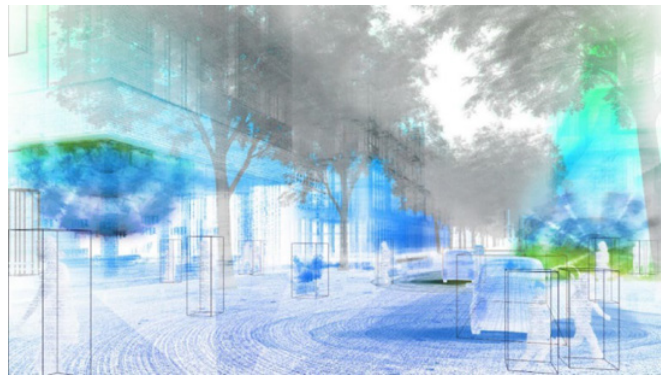
Figure 5 Physical and digital layers Source: (Sidewalk Labs, 2017, p.71). Credit: Sidewalk